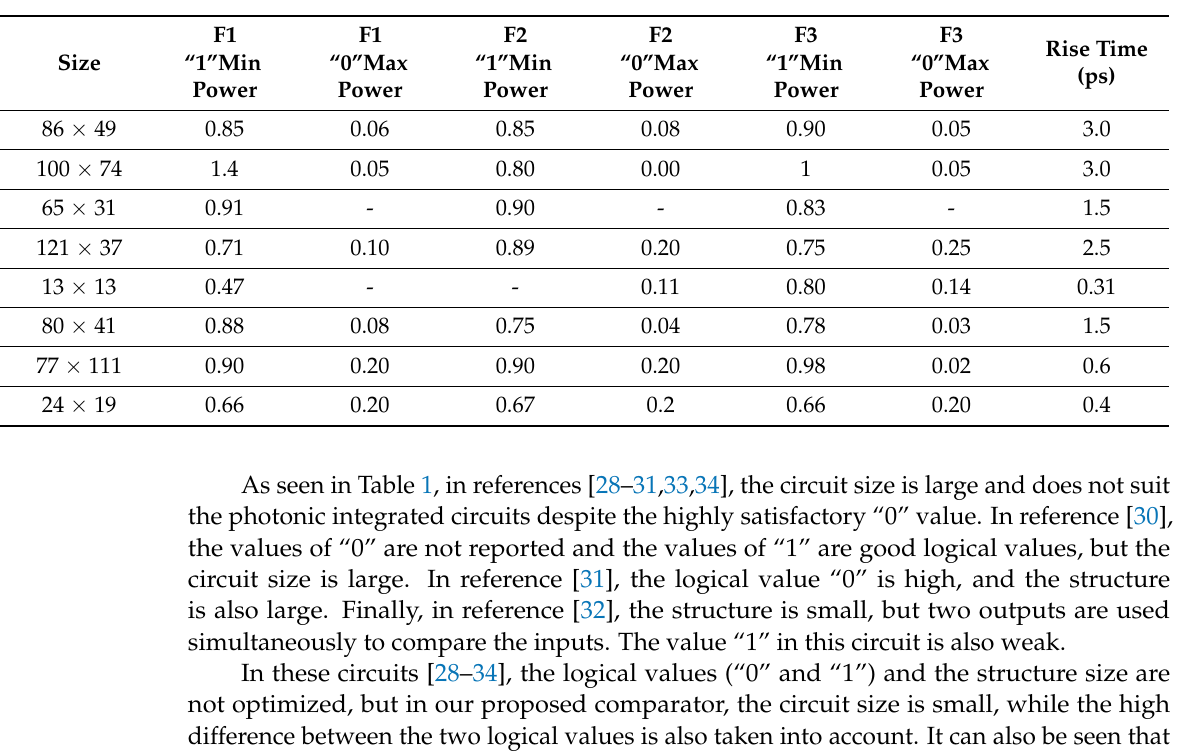
Table 1. Comparison the proposed comparator with other